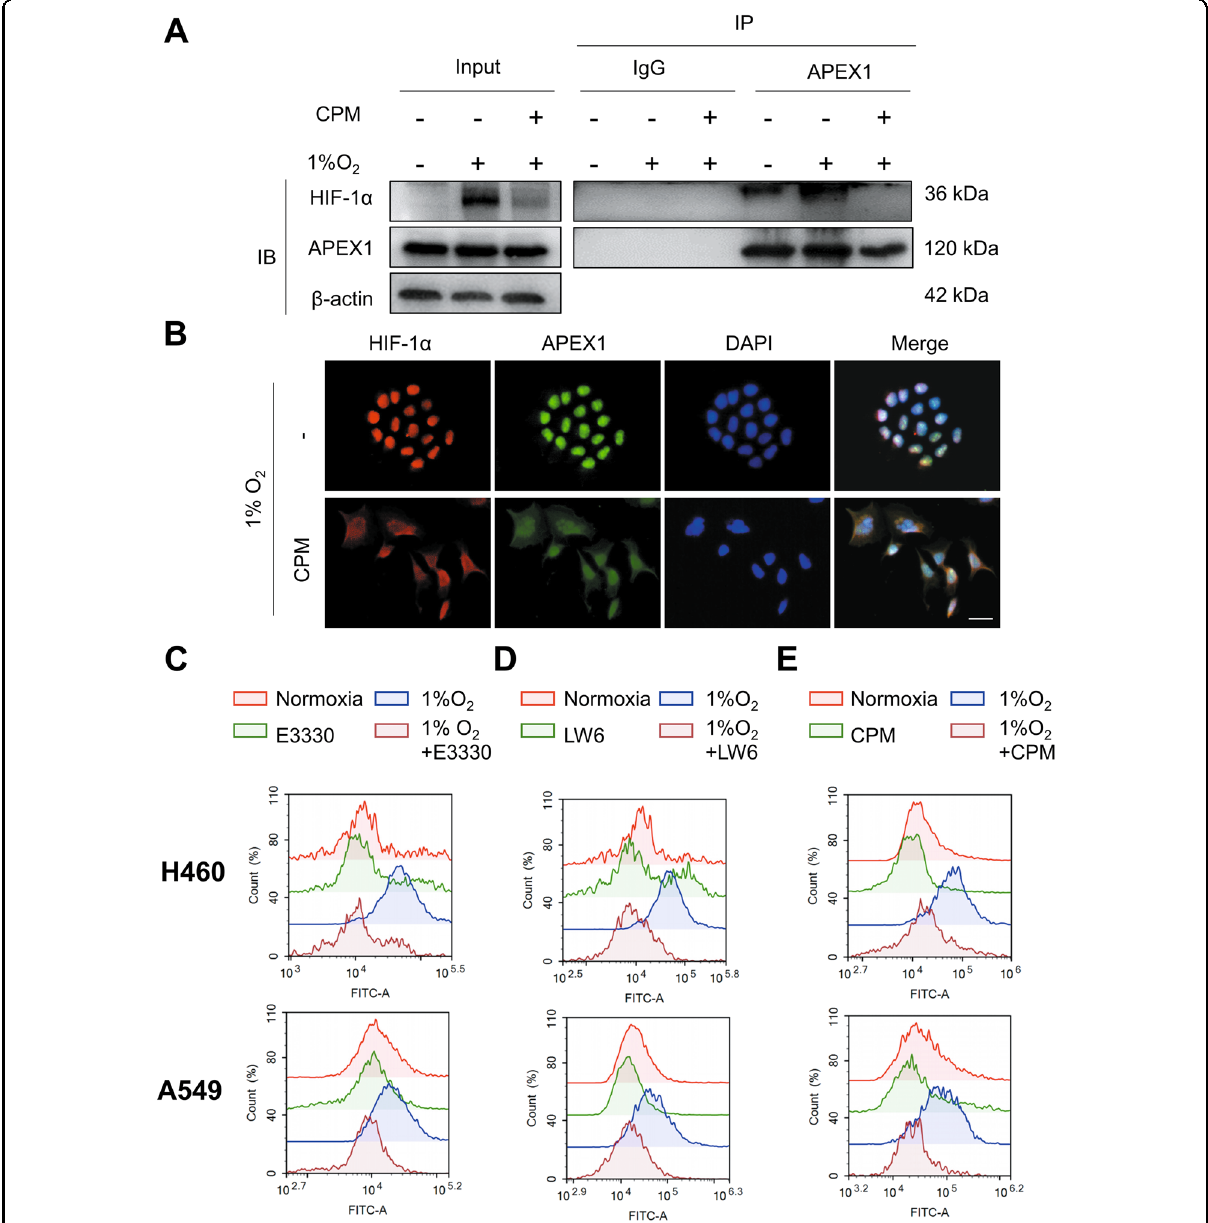
Fig. 3 CPM inhibited APEX1/HIF-1 α interaction and reactive oxygen species (ROS) in LC cells. A Cell extracts from H460 cells treated with CPM under hypoxia were immunoprecipitated with anti-APEX1 antibody or IgG. The IP complex was analyzed for HIF-1 α or APEX1 by western blotting. B H460 cells were treated with CPM under hypoxia. Intracellular localization of APEX1 and HIF-1 α was examined by immuno fl uorescence. APEX1 (green), HIF-1 α (red), DAPI (blue) staining, and 3-channel merged images indicated the nuclear colocalization. C H460 and A549 cells were treated with E3330 under normoxia and hypoxia. D H460 and A549 LC cells were treated with LW6 under normoxia and hypoxia. E LC cells H460 and A549 treated with CPM under normoxia and hypoxia. Cells were stained with 10 μ M DCFH-DA and measured with a fl ow